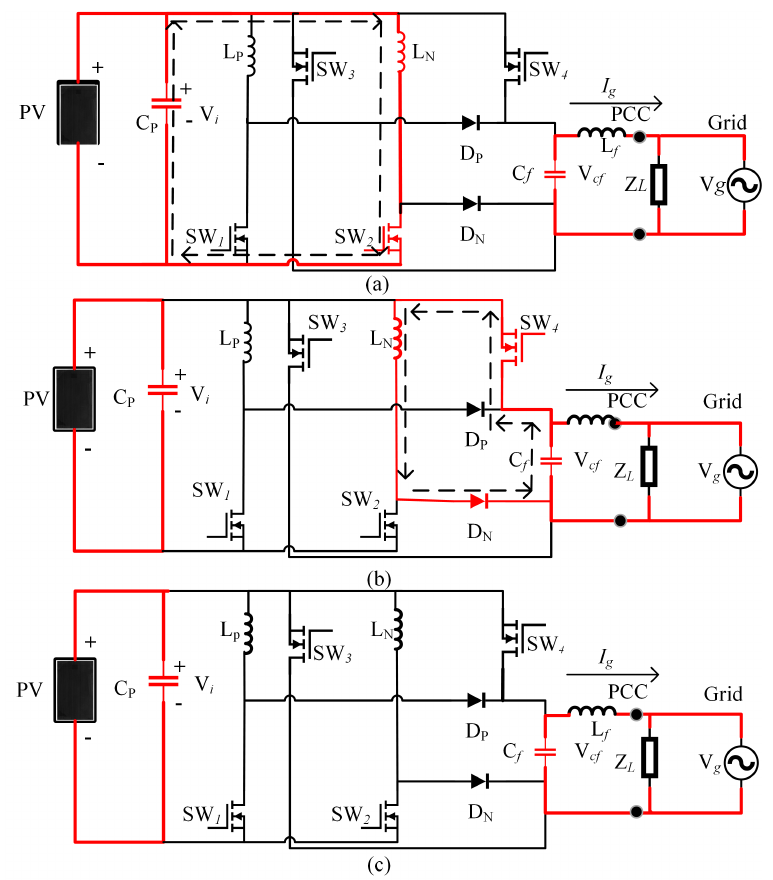
Figure 3. ( a ) Circuits that are equivalent to Mode N 1 . ( b ) Circuits that are equivalent to Mode N 2 . ( c ) Circuits that are equivalent to Mode N 3